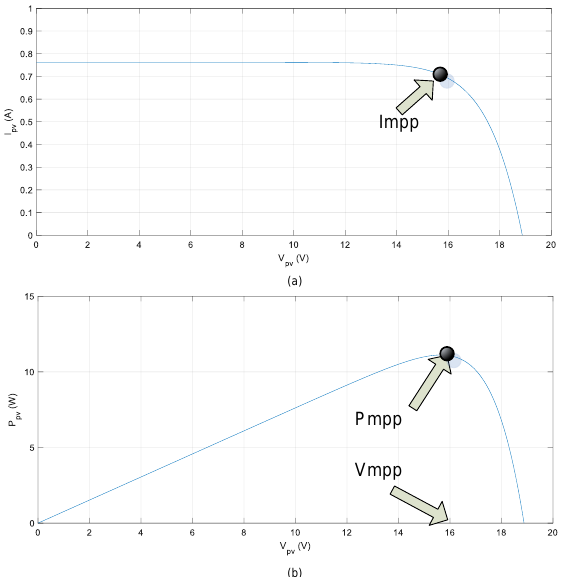
Figure 3. Characteristic curves of a photovoltaic module: ( a ) voltage-current curve, ( b ) voltage- power